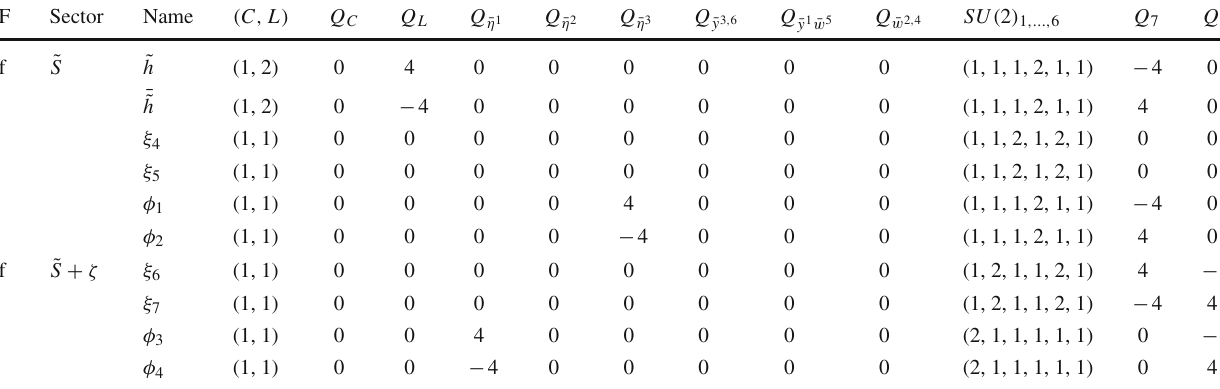
Table 2 The ˜ S and ˜ S + ξ sectors. All charges are multipled by 4 and the combination ζ = 1 + b 1 + b 2 + b 3 has been